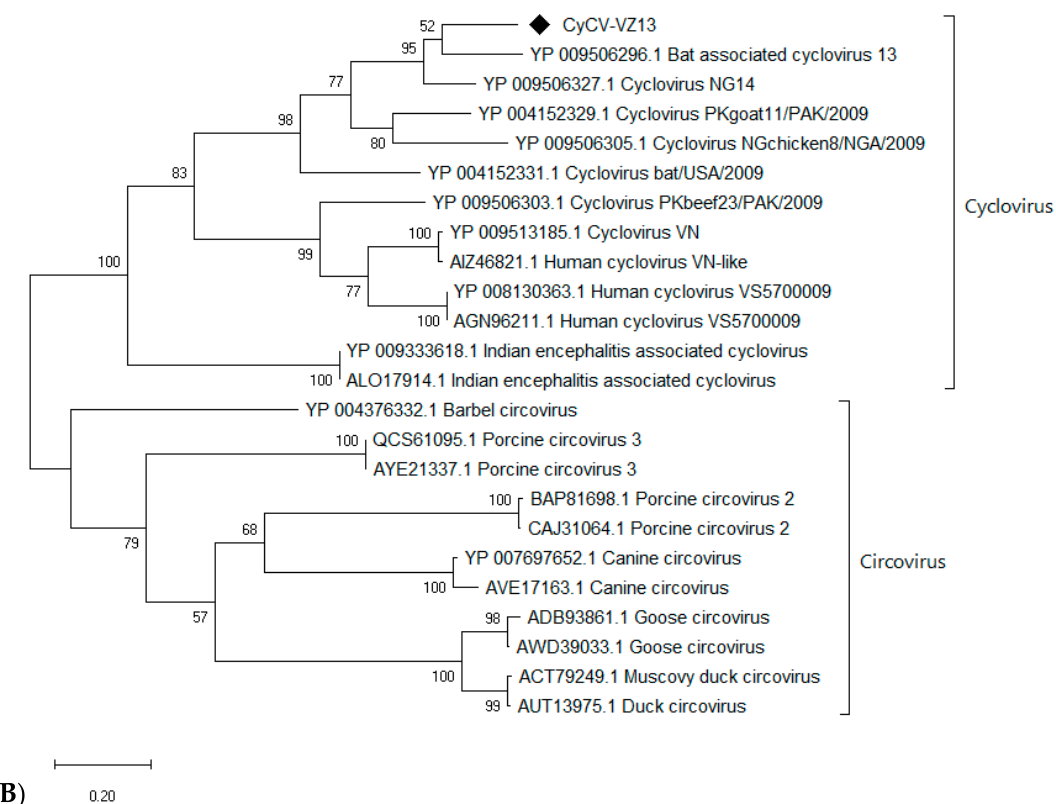
Figure 2. Phylogenetic tree of capsid ( A ) and replication ( B ) protein of Cyclovirus VIZIONS-2013 (CyCV-VZ13) compared to known viruses of the Circoviridae family.